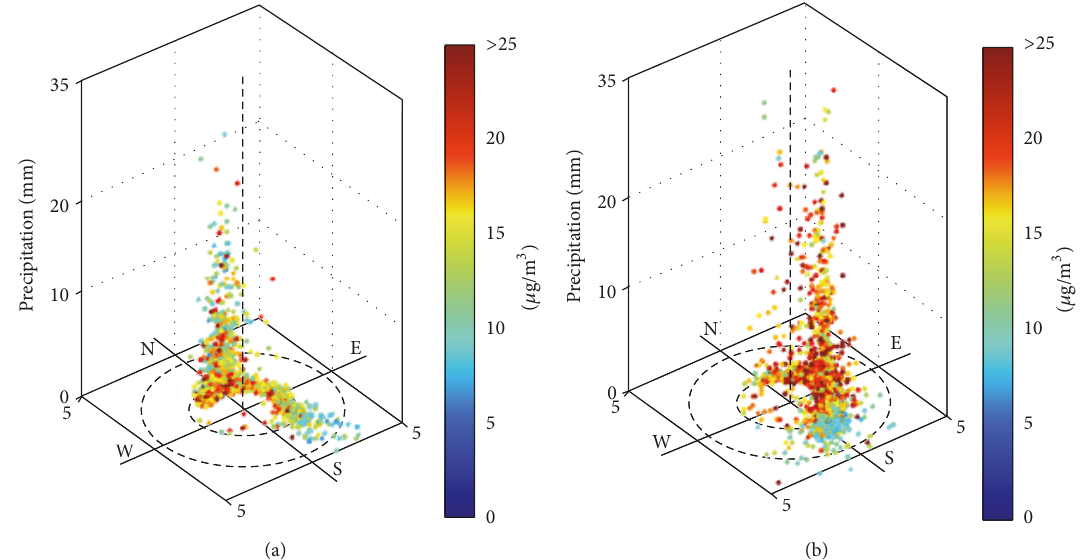
Figure 2: Data distribution for (a) Cotocollao and (b) Belisario, in terms of wind direction, wind speed, precipitation, and PM 2.5 concentrations (color scale). The inner circle represents wind speeds up to 2 m/s and the outer circle represents wind speeds up to 4m/s.